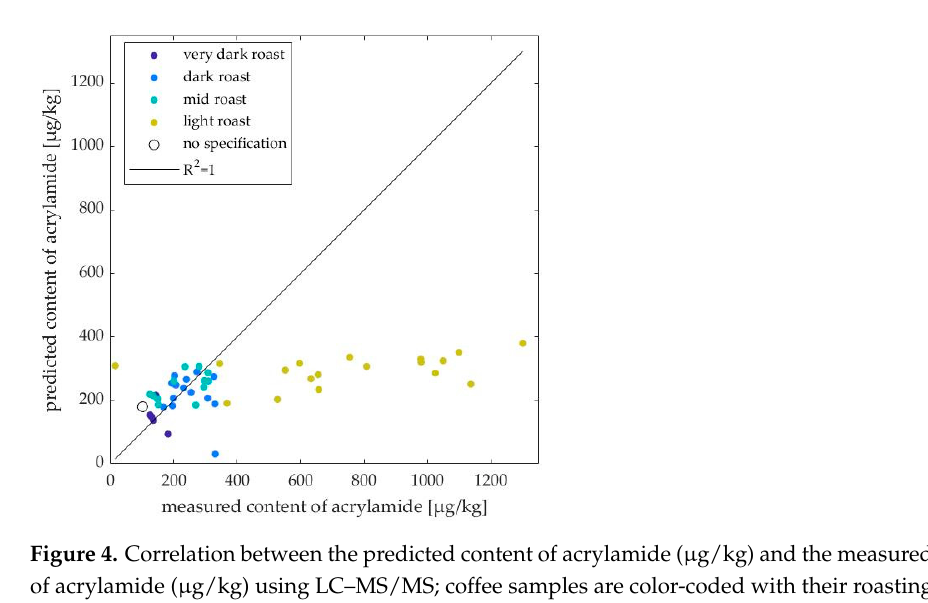
tent of acrylamide (µg/kg) using LC–MS/MS; coffee samples are color-coded with their roasting